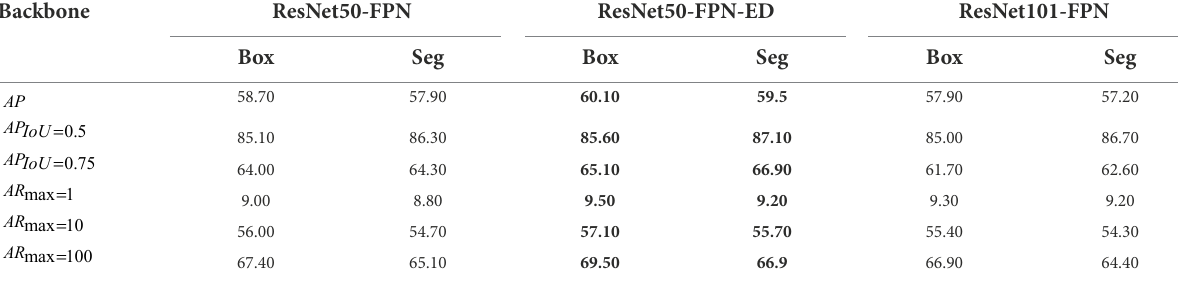
TABLE 4 Test results for different backbones on Mask R-CNN (the best one is highlighted in bold, the same below). Backbone